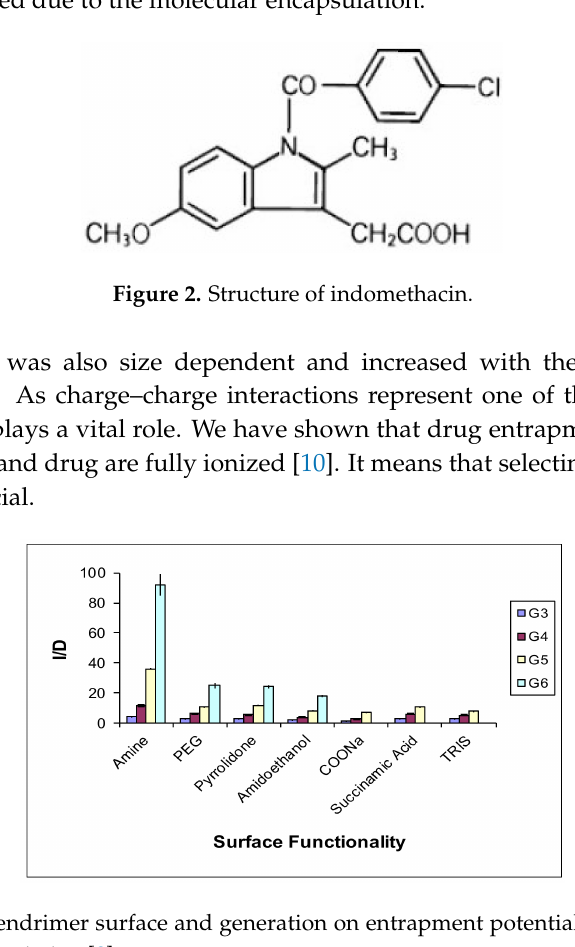
Figure 3. Effect of dendrimer surface and generation on entrapment potential (I/D) of dendrimers. Reproduced with permission [8].